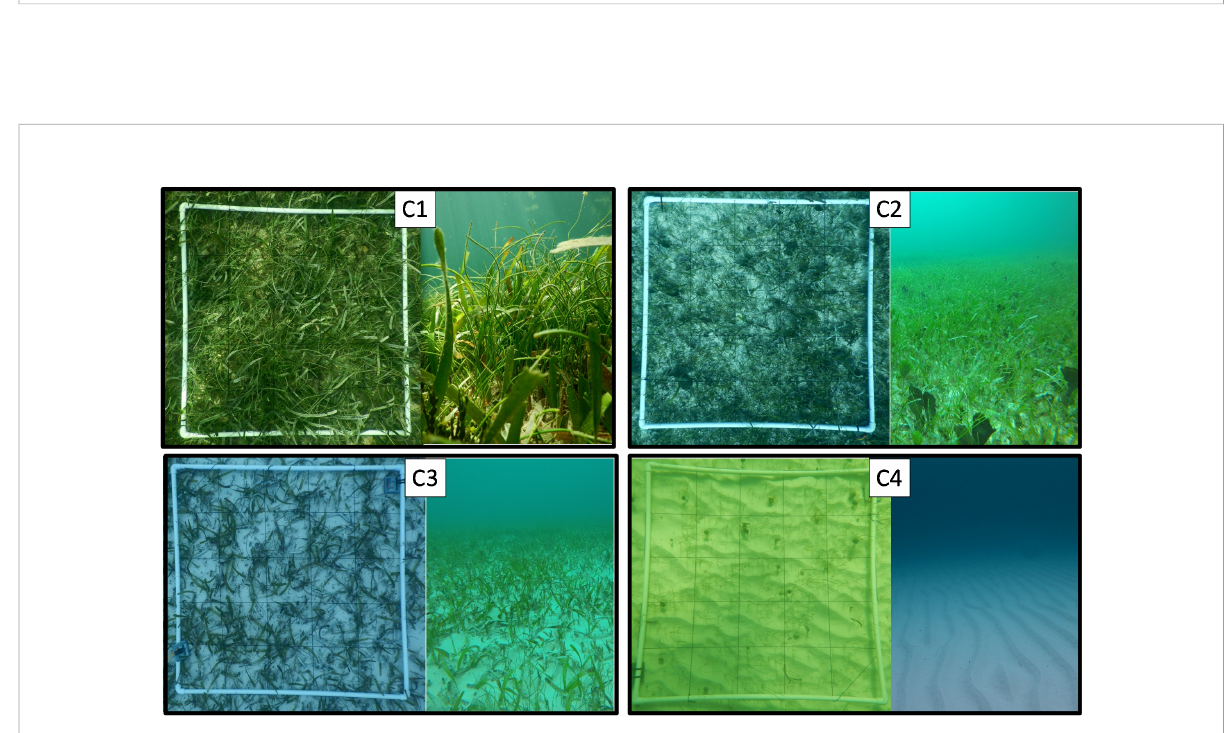
FIGURE 7 Examples of each multiparameter classes: C1 (Dense seagrasses), C2 (Dense mixed vegetation), C3 (Low density seagrasses and algae) and C4